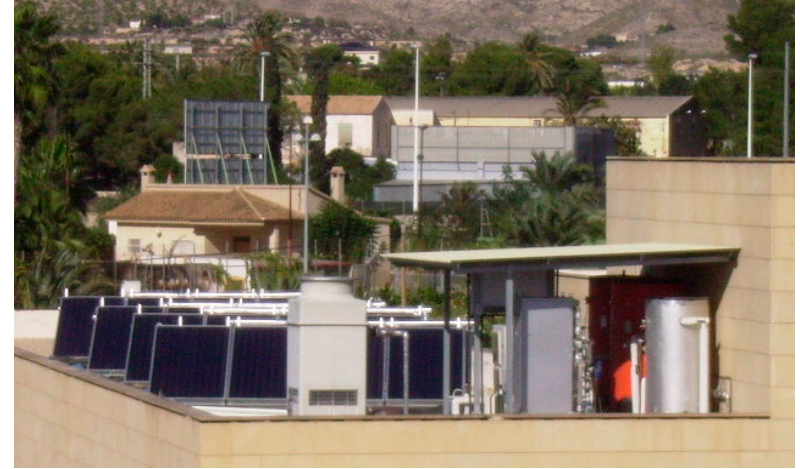
Figure 2. View of the solar cooling system at Miguel Hernández University of Elche.